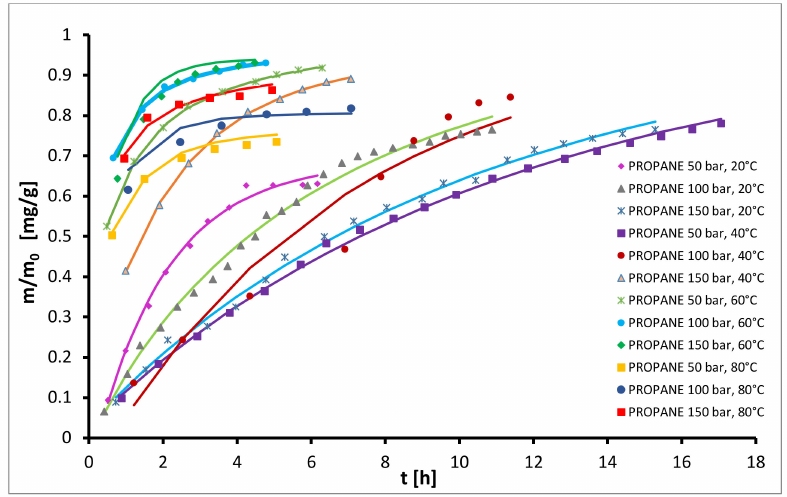
Figure 6. Experimental (symbols) and modelled (lines) kinetic curves for extraction with propane as solvent.